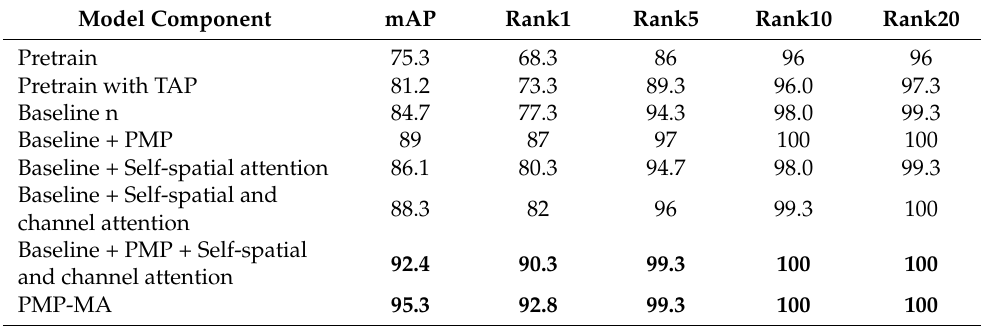
Table 8. The Effects of the Components of the PMP-MA Model on iLIDS-VID.